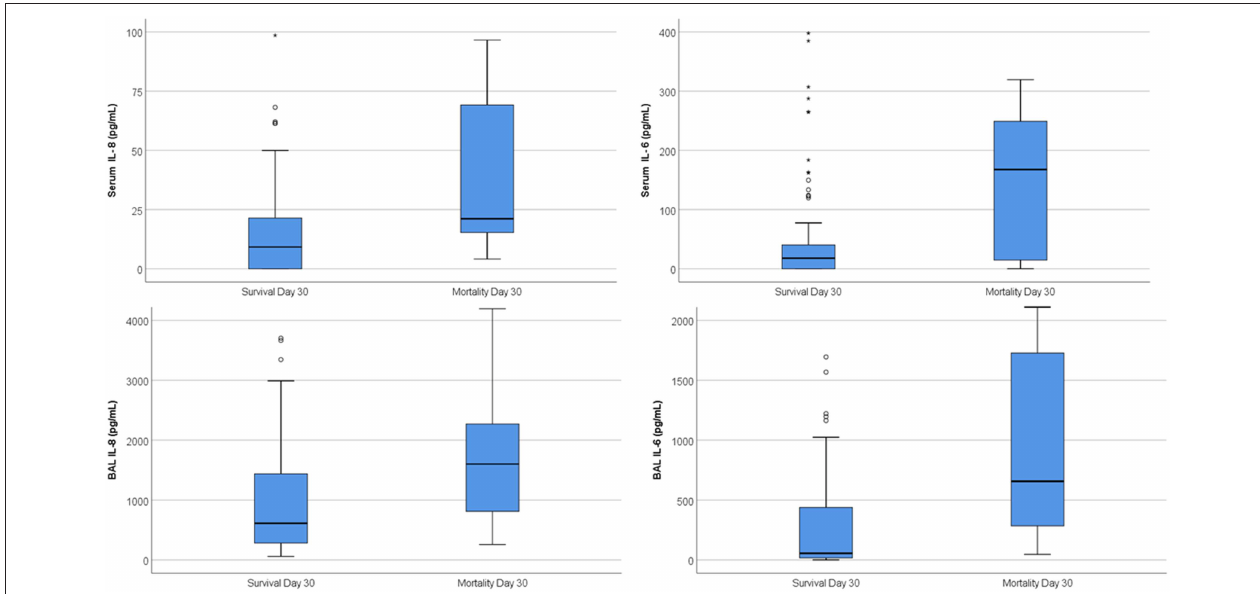
FIGURE 1 | Boxplots of same-day serum and BAL cytokines in those who survived day 30 and those who died. On the boxplot shown here, outliers are identified by different markers. “Out” values (small circle) and “far out” or as SPSS calls them “Extreme values” (marked with a star). SPSS uses a step of 1.5 × IQR (Interquartile range).